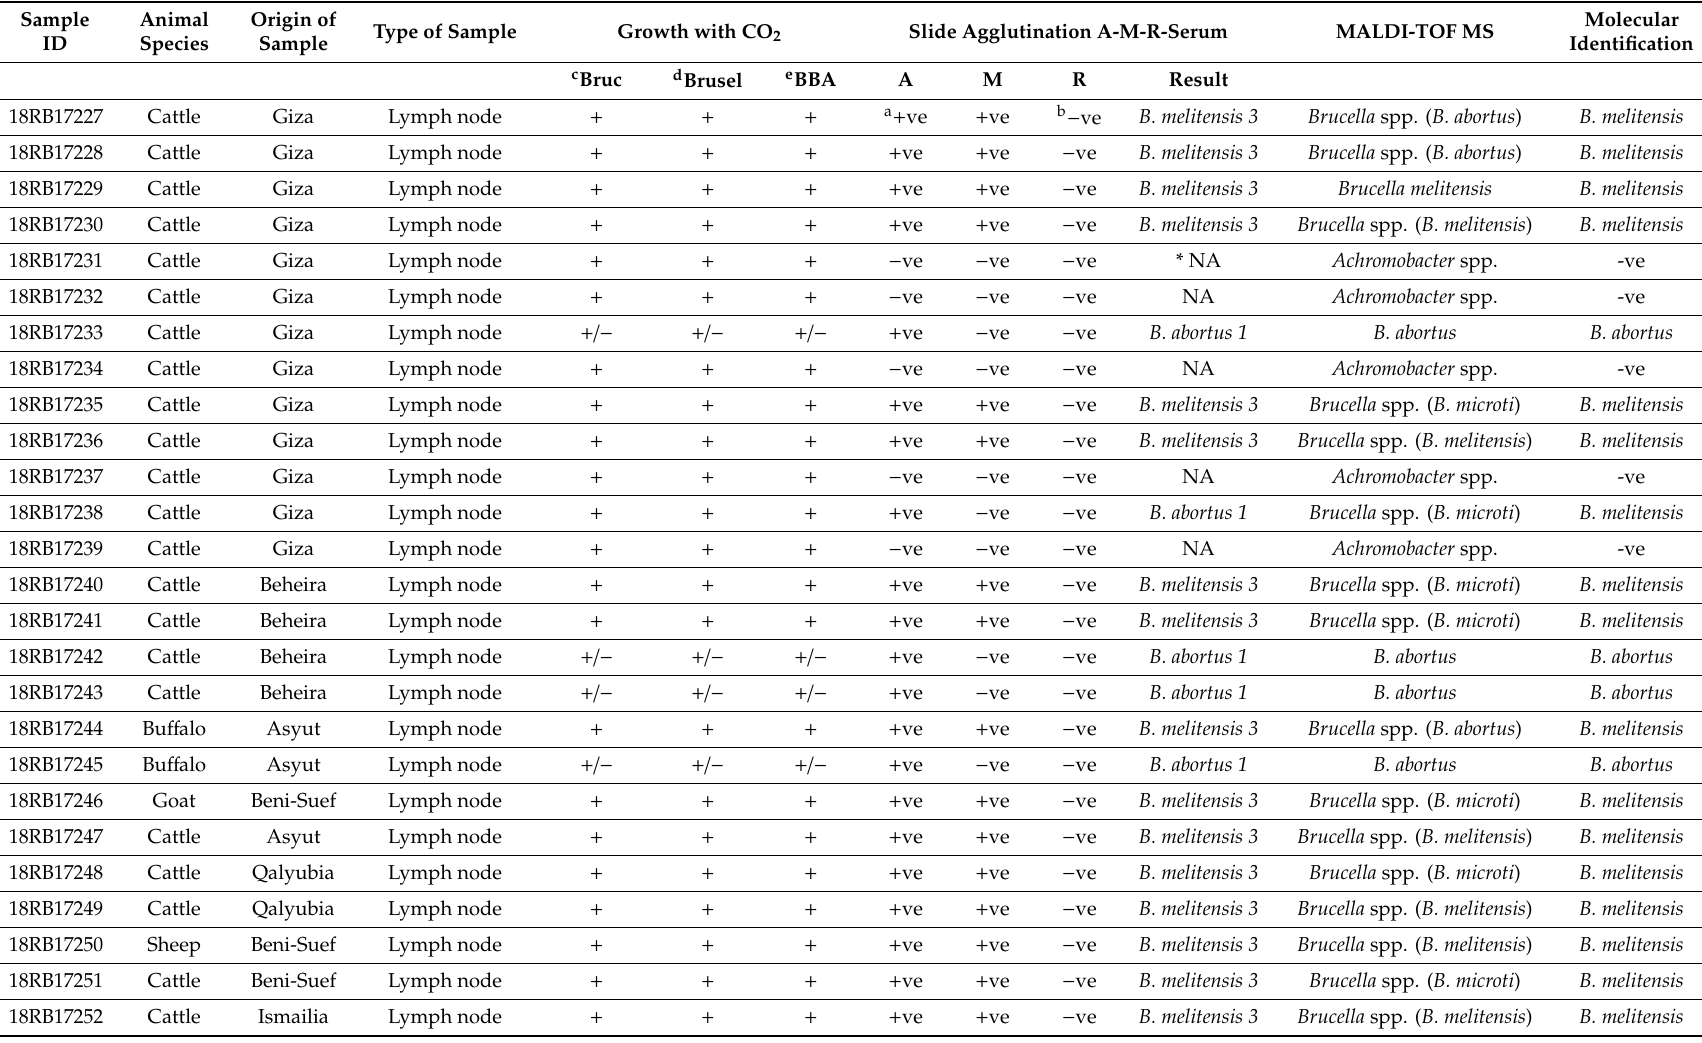
Table 1. Microbiological and molecular identification of Brucella spp. isolated from animal species in